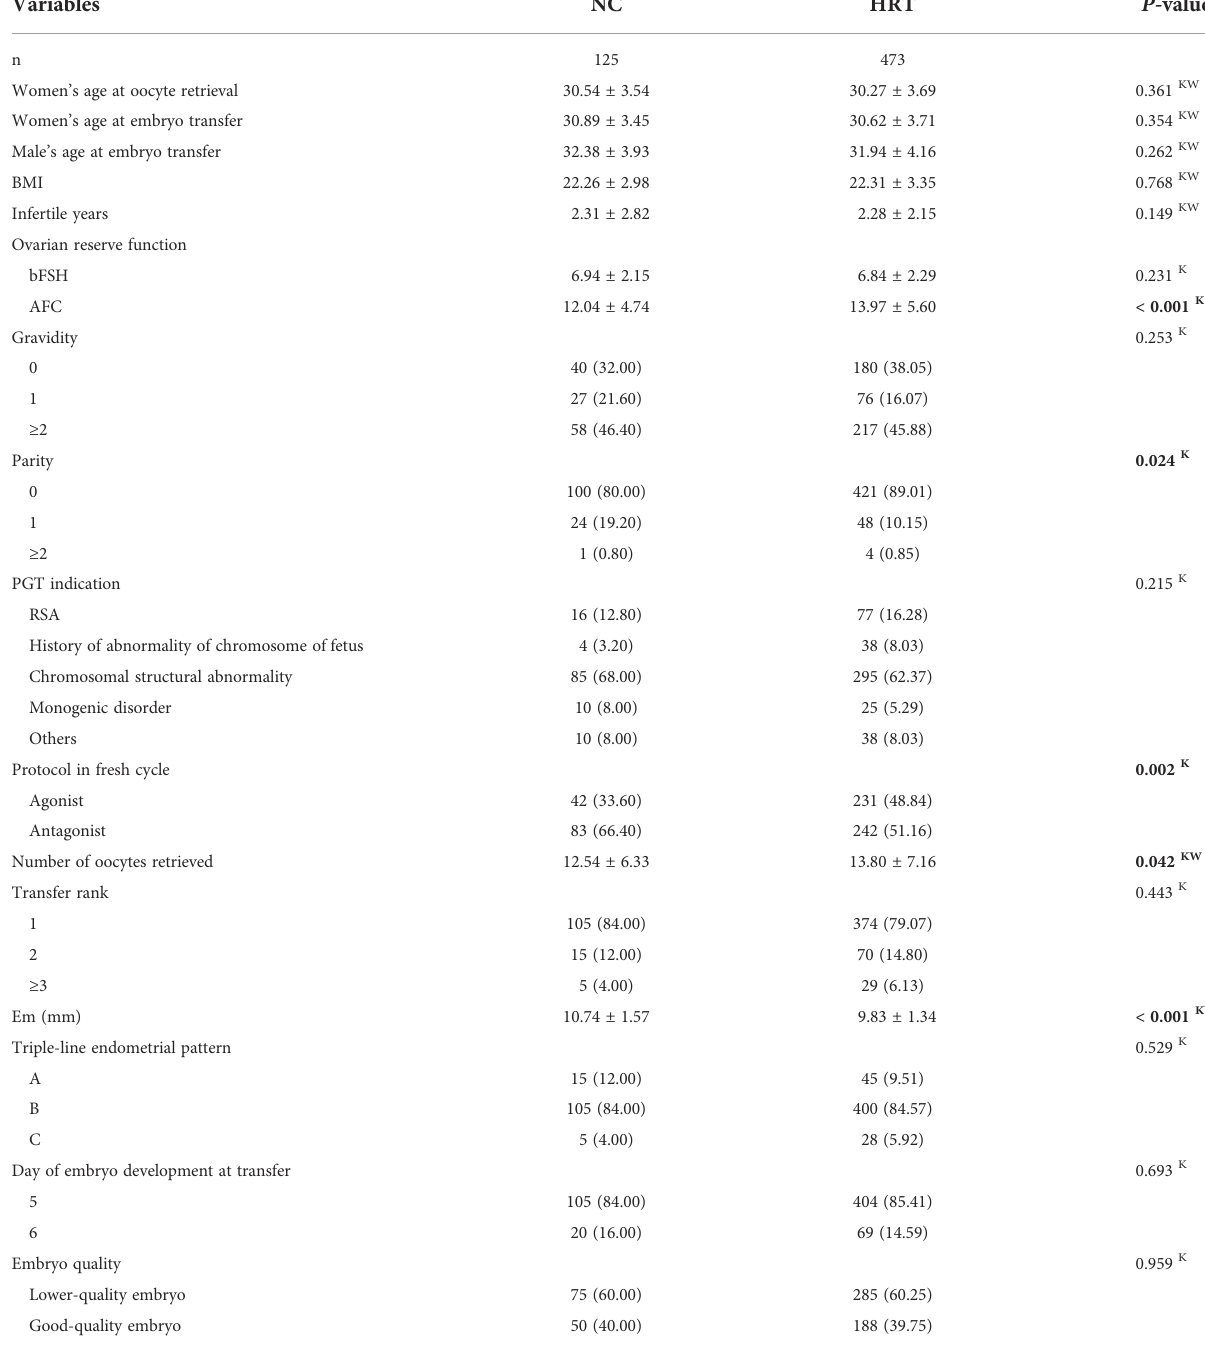
TABLE 1 Characteristics of the patients and assisted reproduction technology cycles (mean ± SEM or